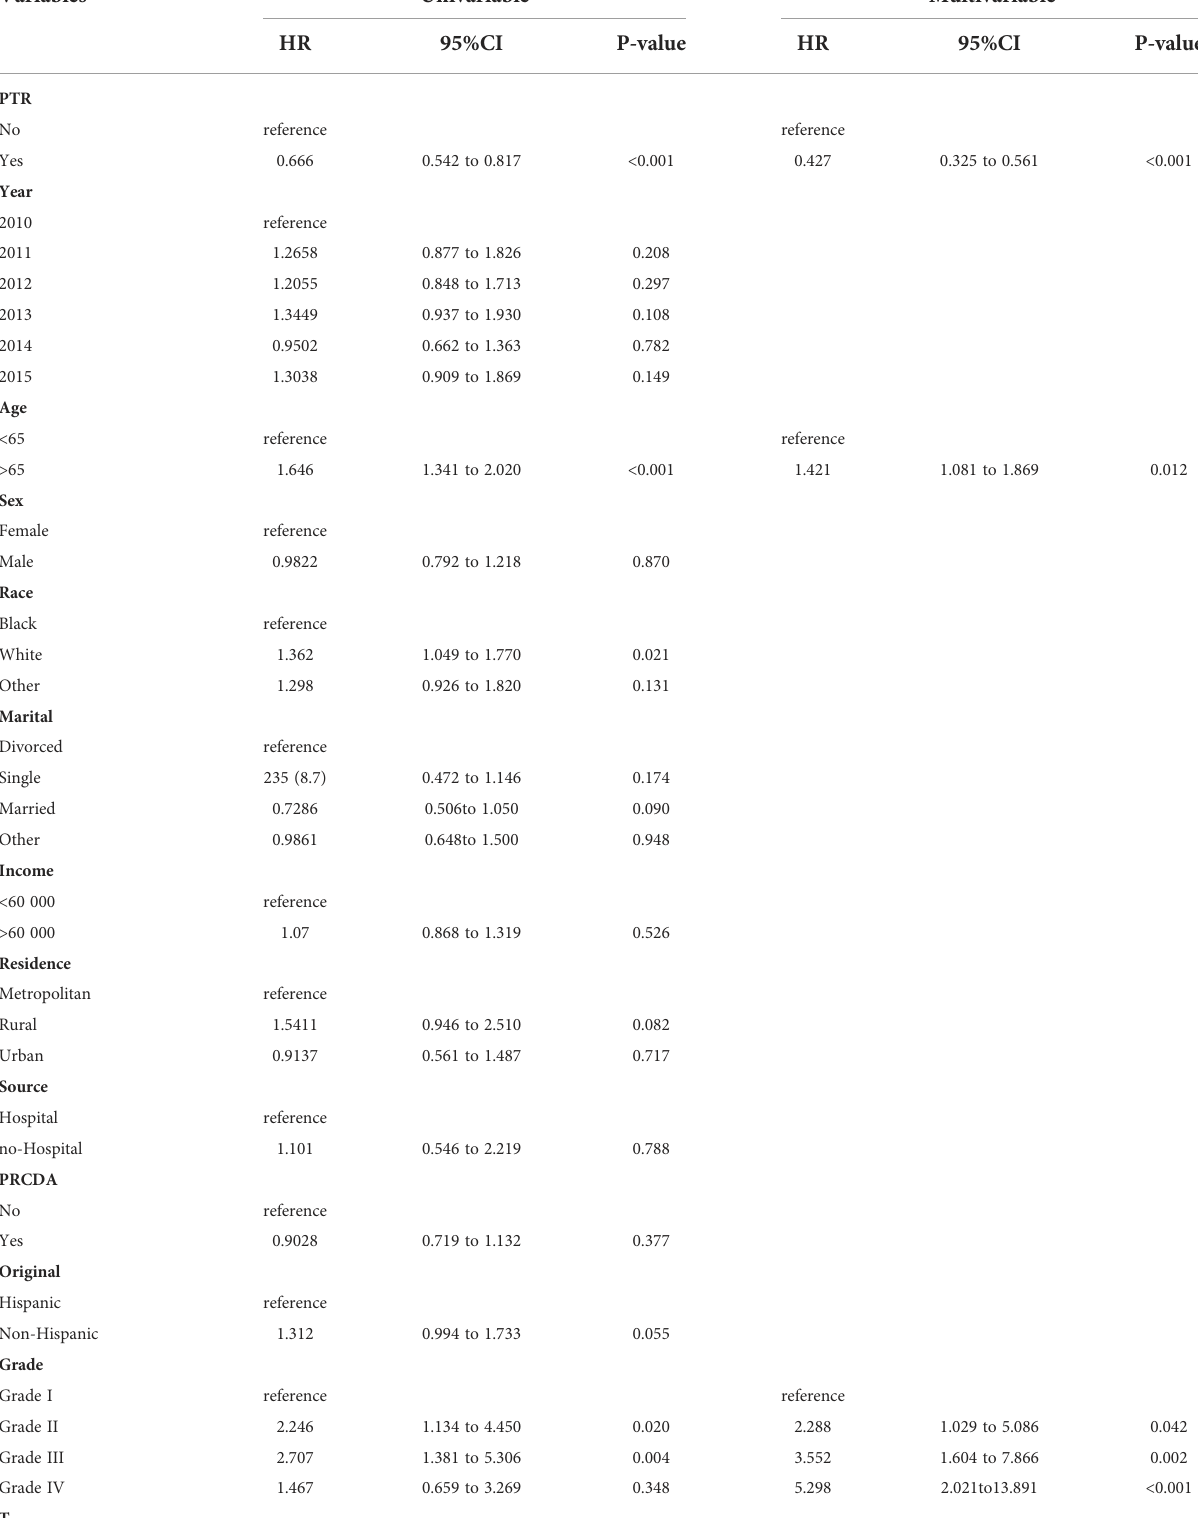
TABLE 2 Univariate and multivariate analysis of prognostic factors for OS in the propensity score matched